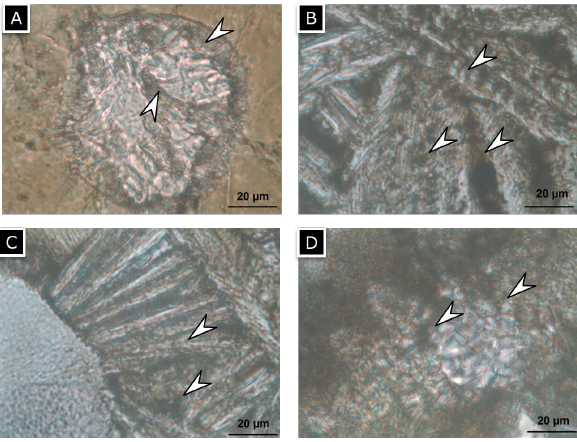
Figure 5. Putative mineralized microbially mediated biosignatures in ALH-77005 meteorite (arrows). The coarse crystals do not contain microbially mediated textures, only near troilite and in melt pocket were detected filamentous, necklace-like iron-oxide-containing textural features resembling to microbially mediated biosignatures, similarly to the influence of iron-oxidizing microbes (transmitted light). A: Coccoidal iron-oxiding bacteria (FeOB) in melt inclusion of brown olivine. B: Filamentous FeOB in melt pocket. C: FeOB along crystallite needles D: FeOB with organic material in melt pocket. The signs of FeOB are marked by